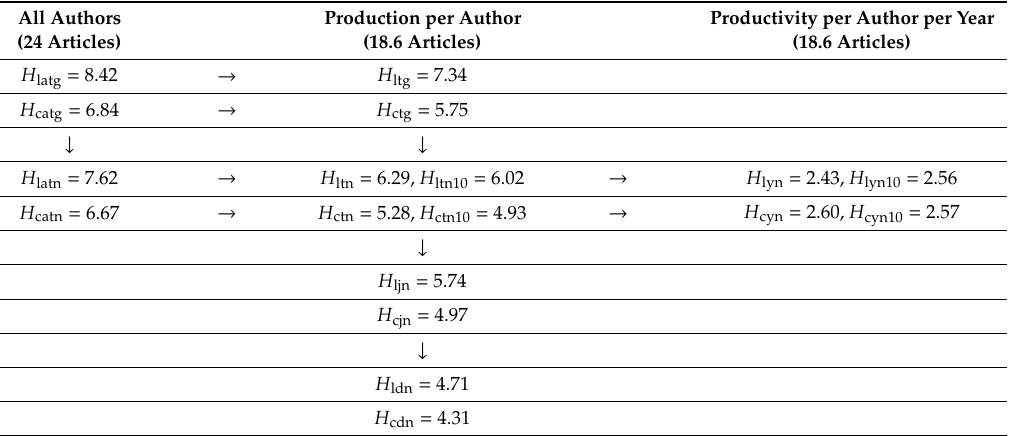
Table A2. Summary of the H index values calculated for the first analyzed PH (Table A1) over